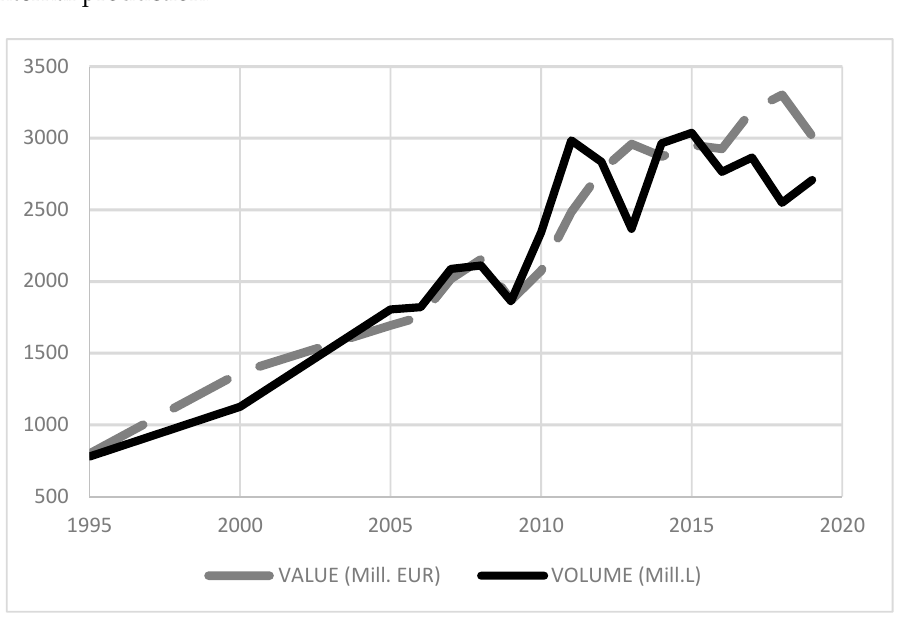
Figure 1. Variation in wine exports, 1995–2019.